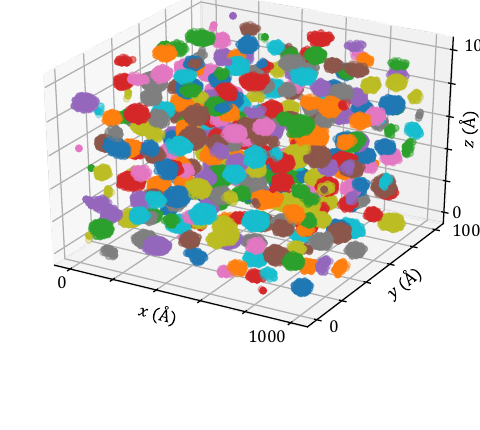
Figure 4. Aggregation kinetic of ( A ) Ti number of clusters present in the simulation box (solid black line) and their average size (blue circles). Note that in the latter the NPs formed a single cluster after approximately 7 µ s of simulations.